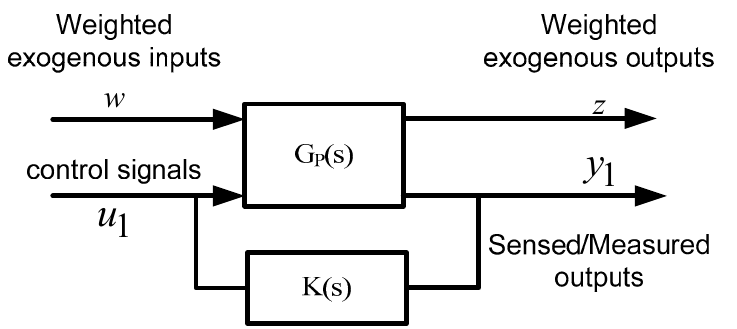
Figure 3. General setup of the H ∞ design problem.